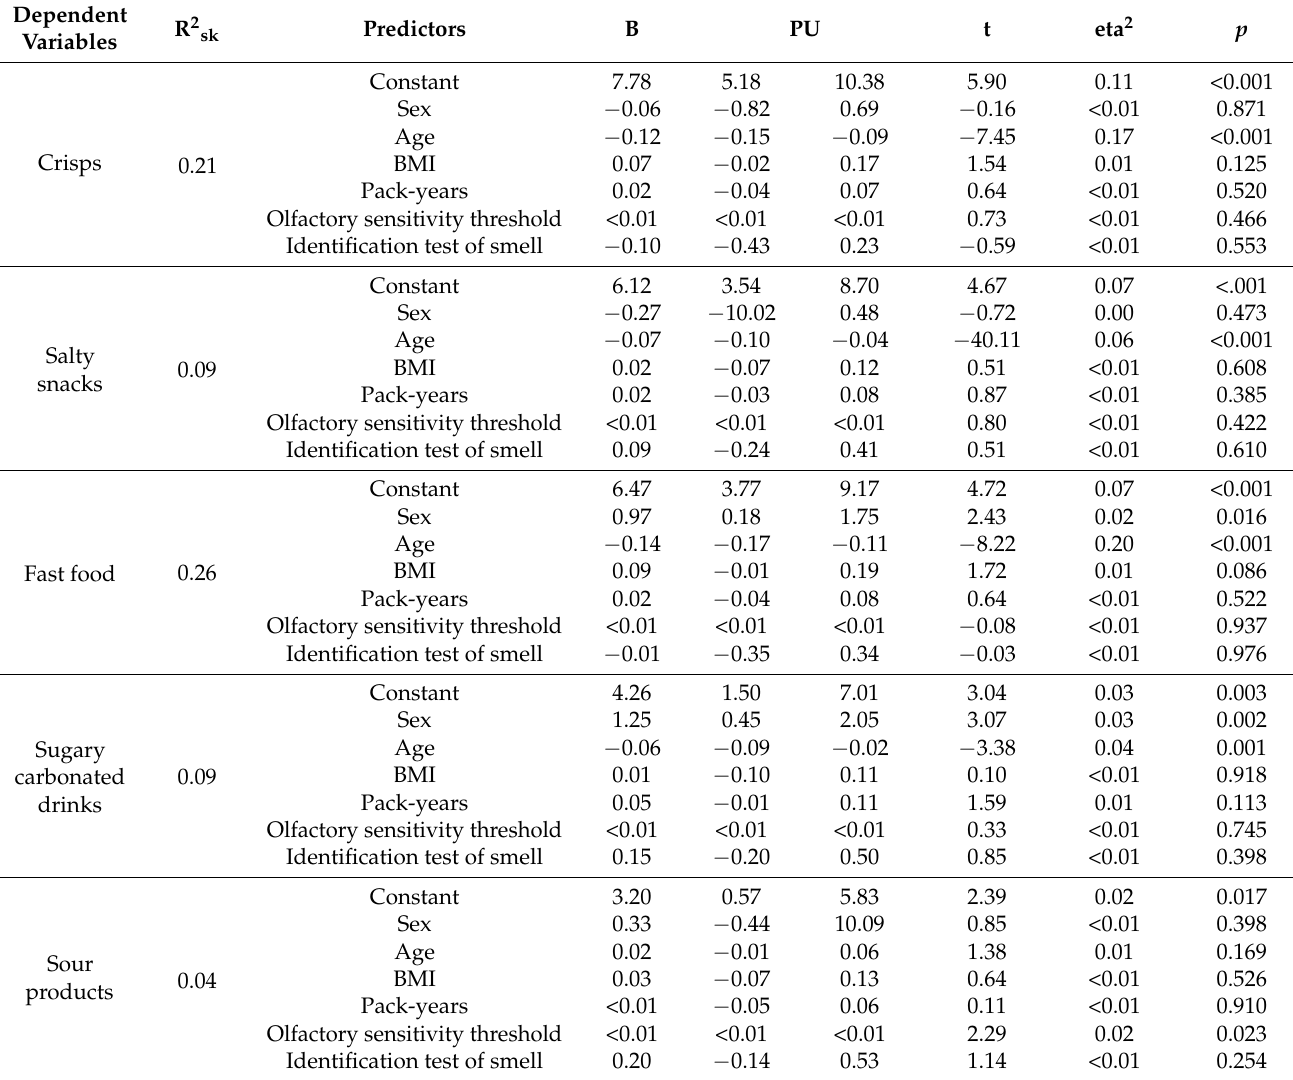
Table 4. Influence of predictors such as sex, age, BMI, pack-years, n-butanol dilution step, odour iden- tification on the declared pleasure of individual dishes identified in the factor analysis as Factor One ‘unhealthy food with a strong flavour’; B—Unstandardised regression coefficients; PU—confidence